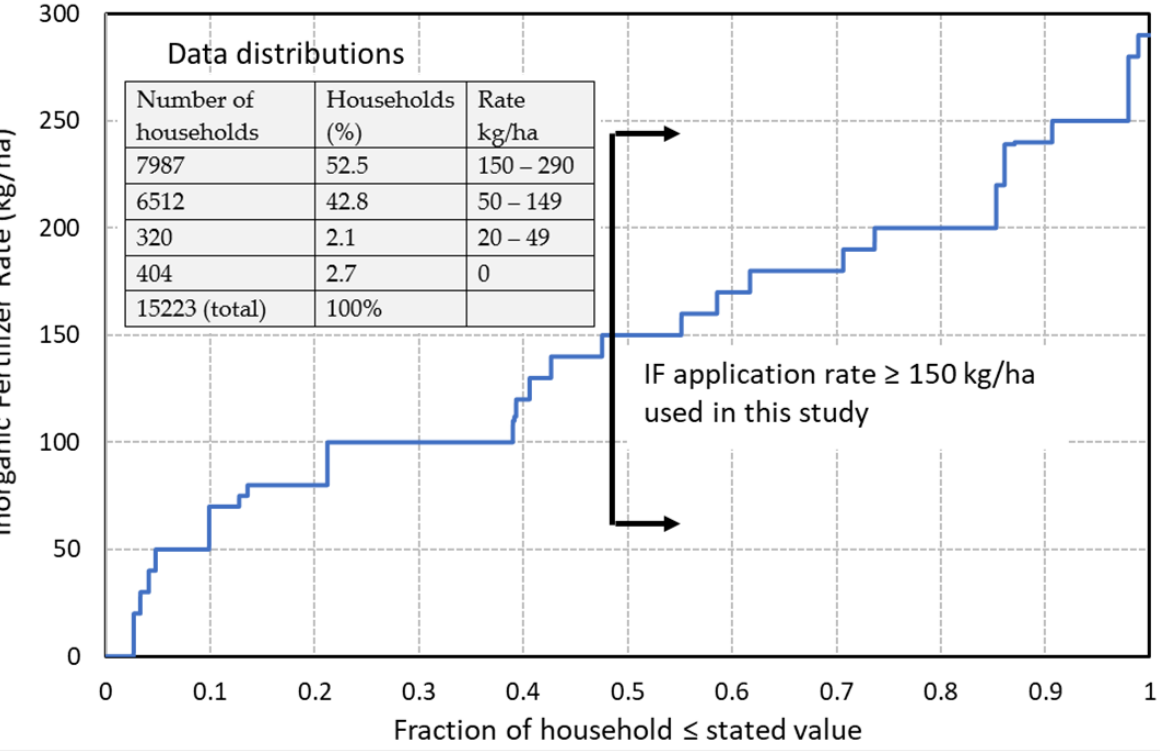
Figure 3. IF application rates of 15,223 farmers/households in the study area. Threshold of 150 kg/ha is the average IF rate for 15,223 farmers ’ application rates .